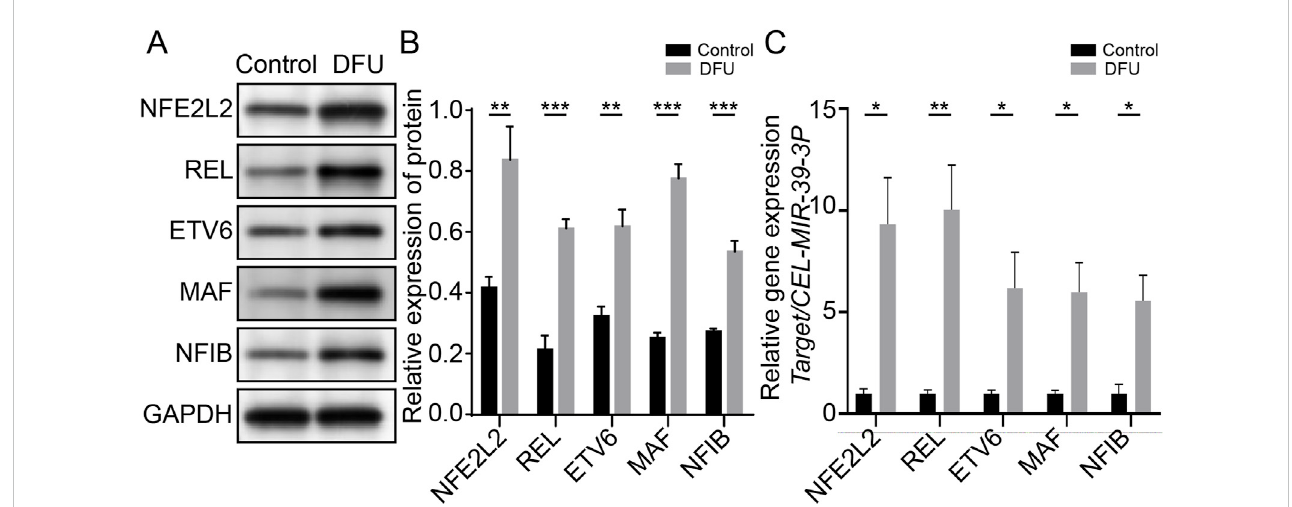
FIGURE 6 Immune-associated genes are associated with relative immune microenvironment for DFUs. (A) Native strips of NFE2L2, REL, ETV6, MAF, and NF1B in WB. (B) BloodofDFUpatientsshowingsigni fi cantlyhigherexpressionlevelsofNFE2L2,REL,ETV6,MAF,andNF1B. (C) qPCRresultsshowedthatNFE2L2,REL, ETV6, and NF1B in the DFU group were signi fi cantly higher than those in the control group.